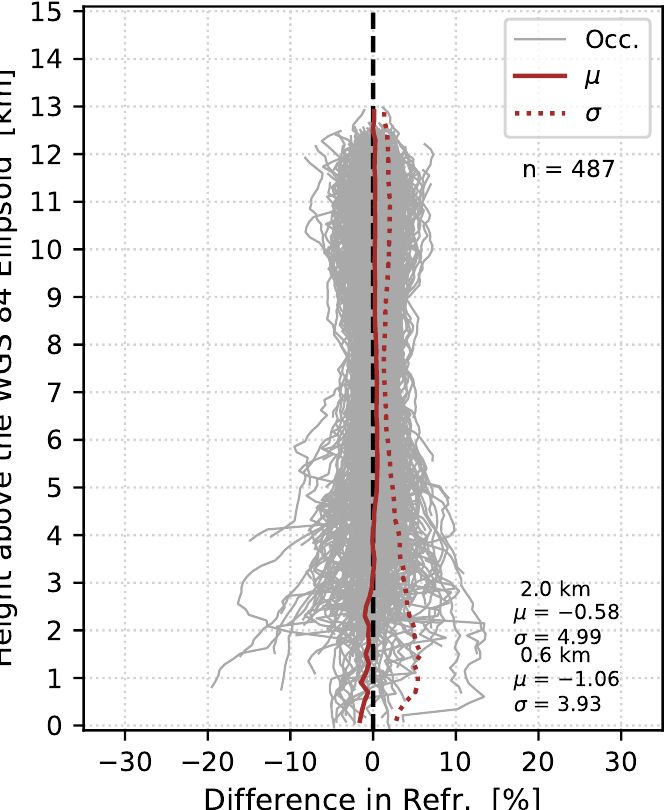
Figure 12. Same as Figure 5 but for airborne radio occultations (ARO) during AR Recon 2020 and their nearest dropsonde that was within a distance threshold of 300